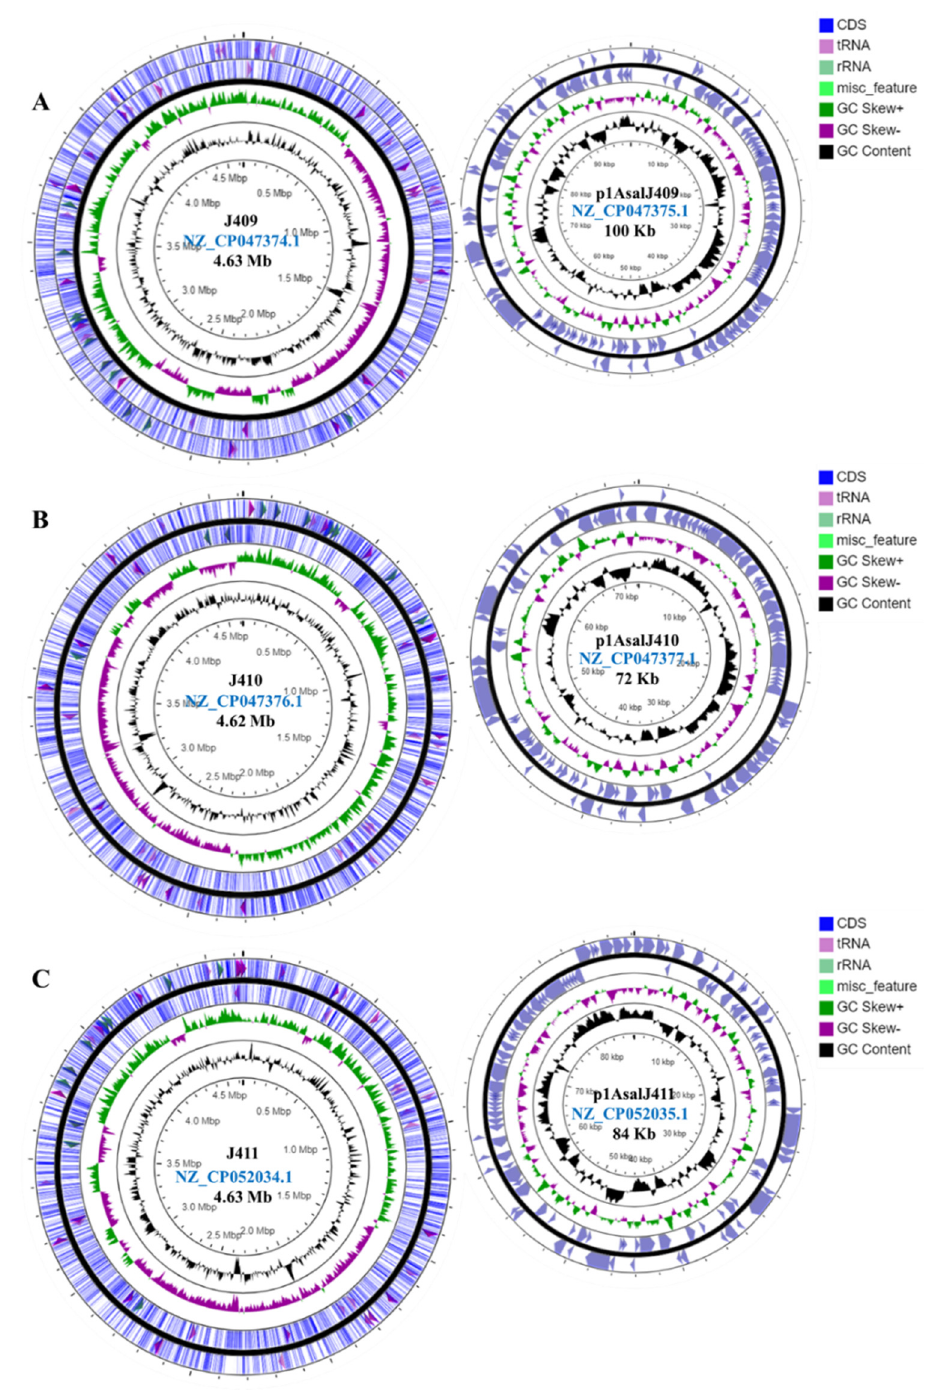
Figure 2. Atypical A. salmonicida genome maps. Genome map visualization of A. salmonicida genome from J409 ( A ), J410 ( B ), and J411 ( C ). Mapping was performed using the CGViewer pipeline. Maps shown in this figure are not scaled to each other. Left maps represent the chromosome and right map the plasmid. Color bars represent CDS (blue); Color arrows indicate tRNAs (magenta) and rRNA (faint green), GC content (black), GC Skew (+) (forest green), and GC Skew ( − )(violet). The typical A. salmonicida plasmid profile showed the presence of a large plasmid (Figure S1D) and three small plasmids (Figure S1E). The chromosome size of A. salmonicida J223 is ~ 4.7 Mb, and the small plasmids pASal1, pASal2, and pASal3 have a molecular